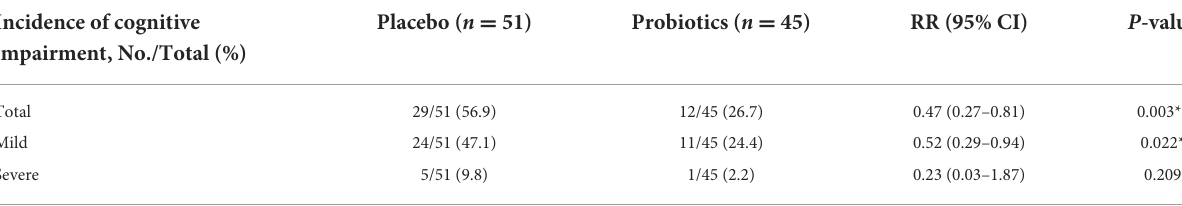
TABLE 4 Probiotics decrease the incidence of POCD in elderly patients after joint arthroplasty. Incidence of